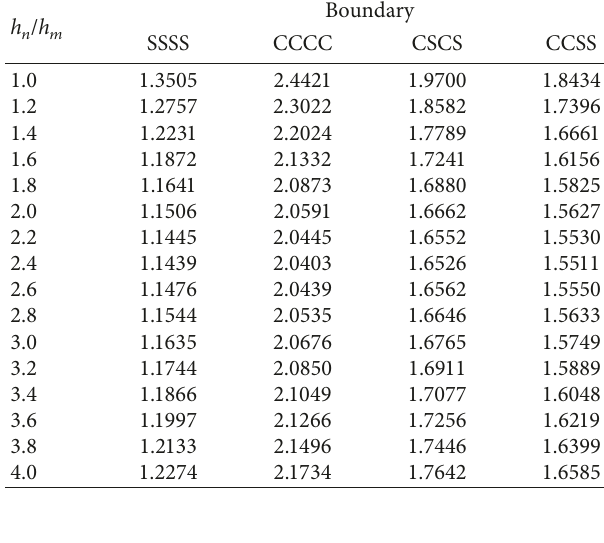
h n / m on nondimensional fundamental / E m � 1. st